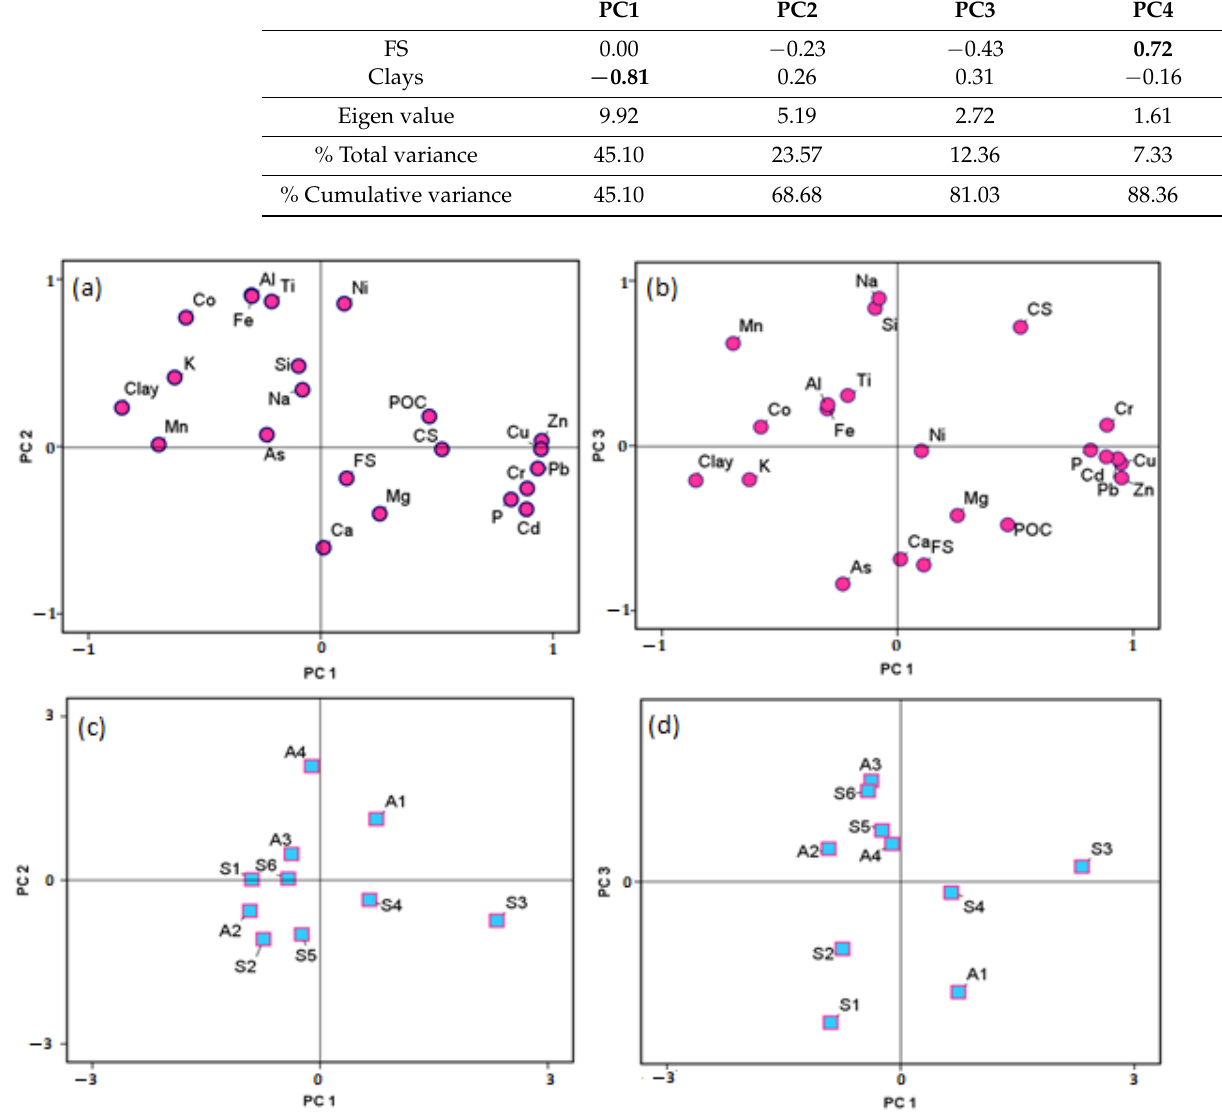
Figure 6. Principal Component Analysis (PCA) for the PC1-PC2 ( a ) and PC1-PC3 ( b ) components, considering the mean concentrations of trace and major elements, the contents of POC, Clays, Fine (FS) and Coarse (CS) Silts in bottom sediments of the Sebou basin; ( c , d ) represent the corresponding sampling stations associated to the same components, respectively.